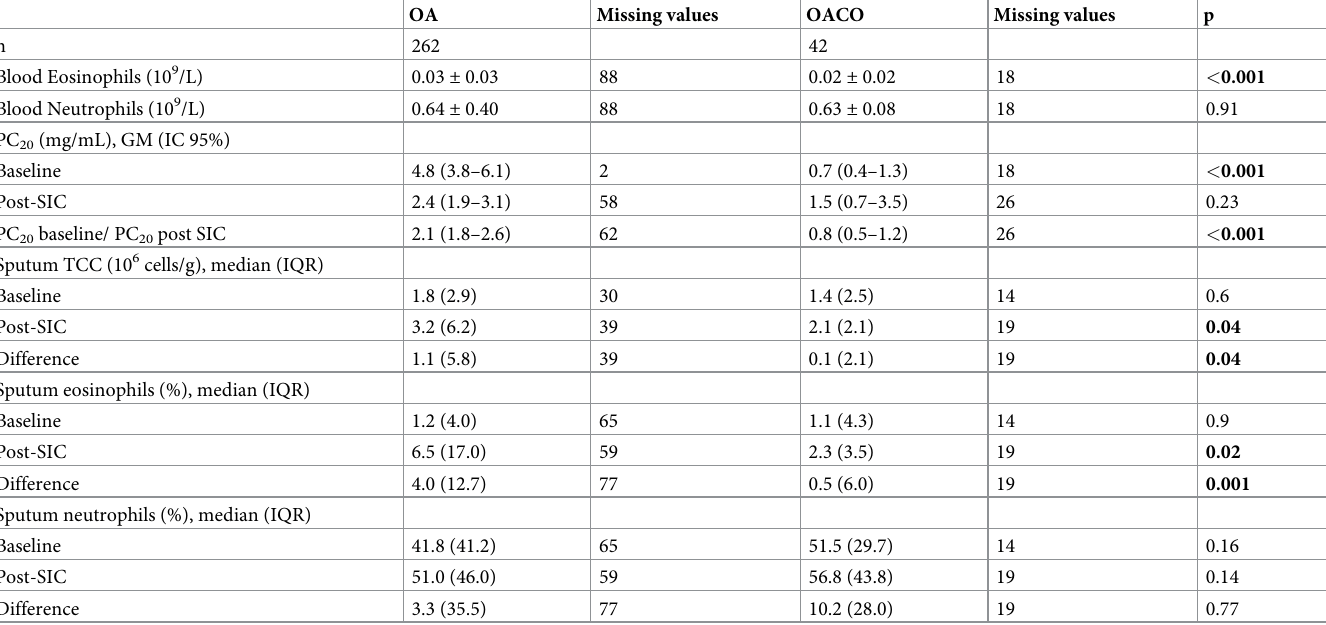
Table 2. Characterization on the airway inflammation on the study population.